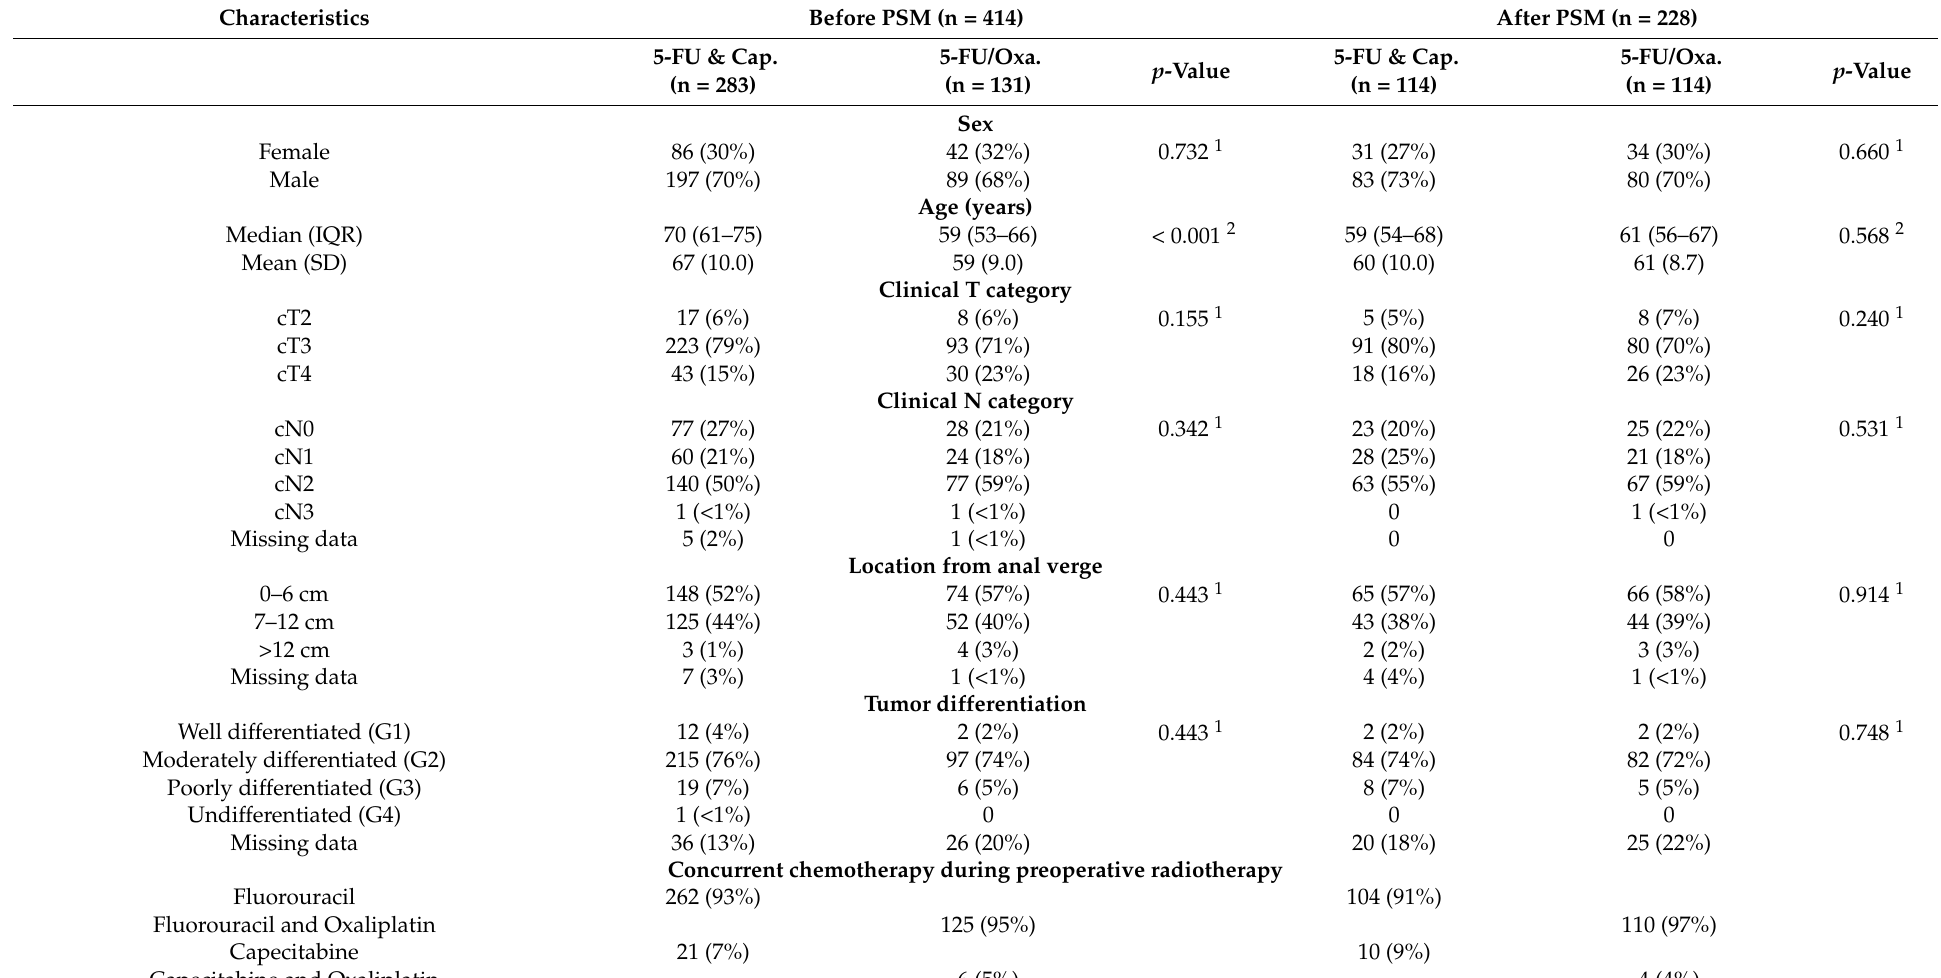
Table 1. Patient characteristics before and after